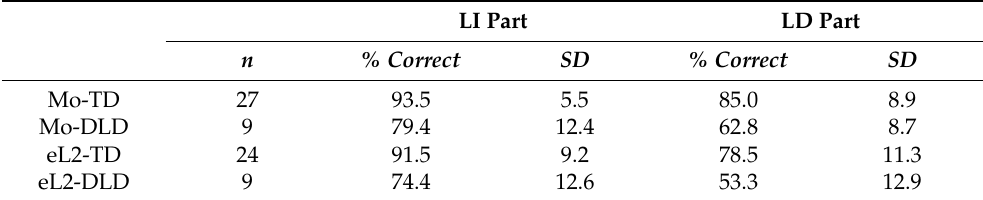
Table 4. Mean percentage of correctly repeated items and SD by group for the language independent (LI) and language-dependent (LD) part.